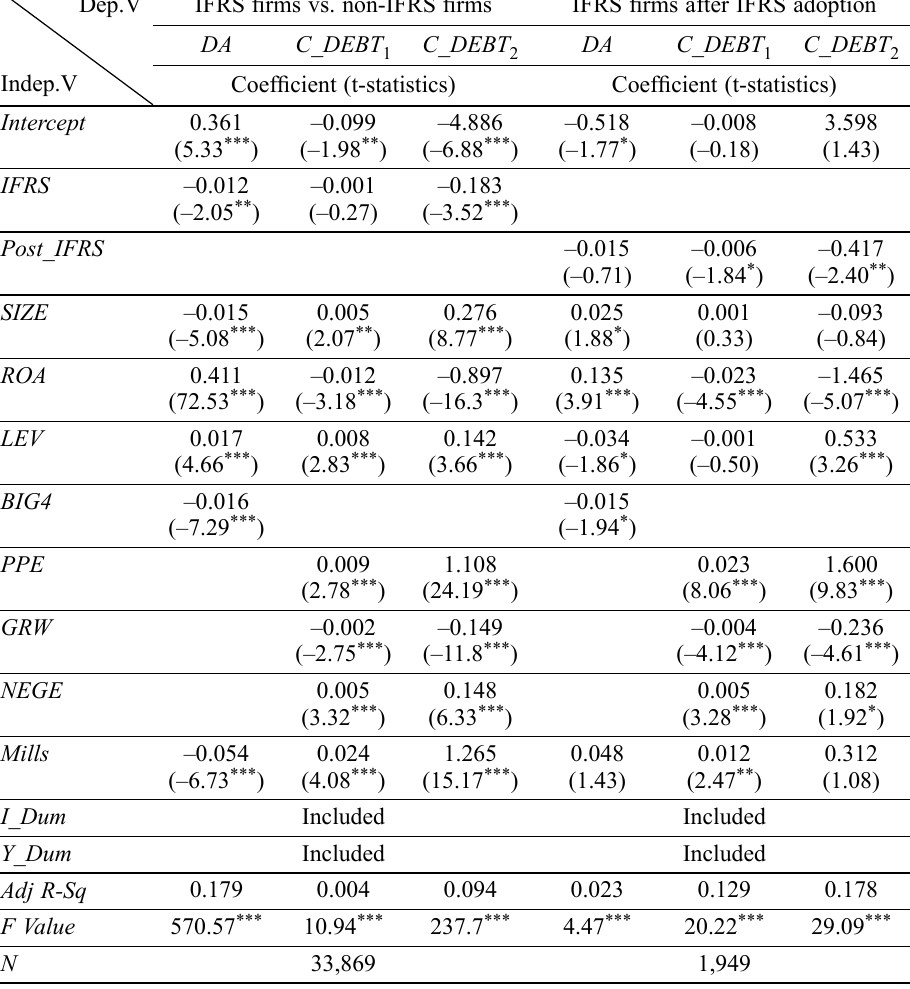
Panel B: Second stage: OLS regression results of IFRS firms vs. non-IFRS firms and OLS regression results of IFRS firms after IFRS